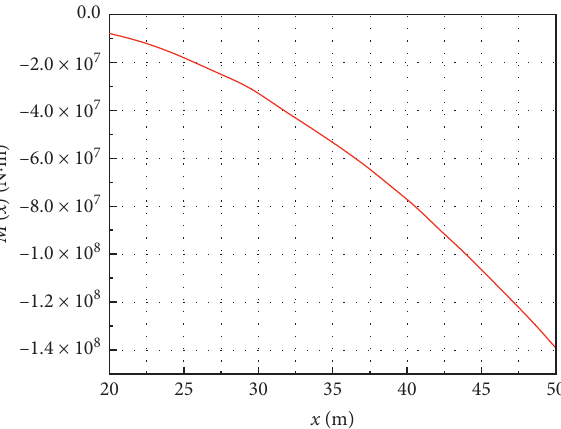
Figure 12: The variation of bending moment